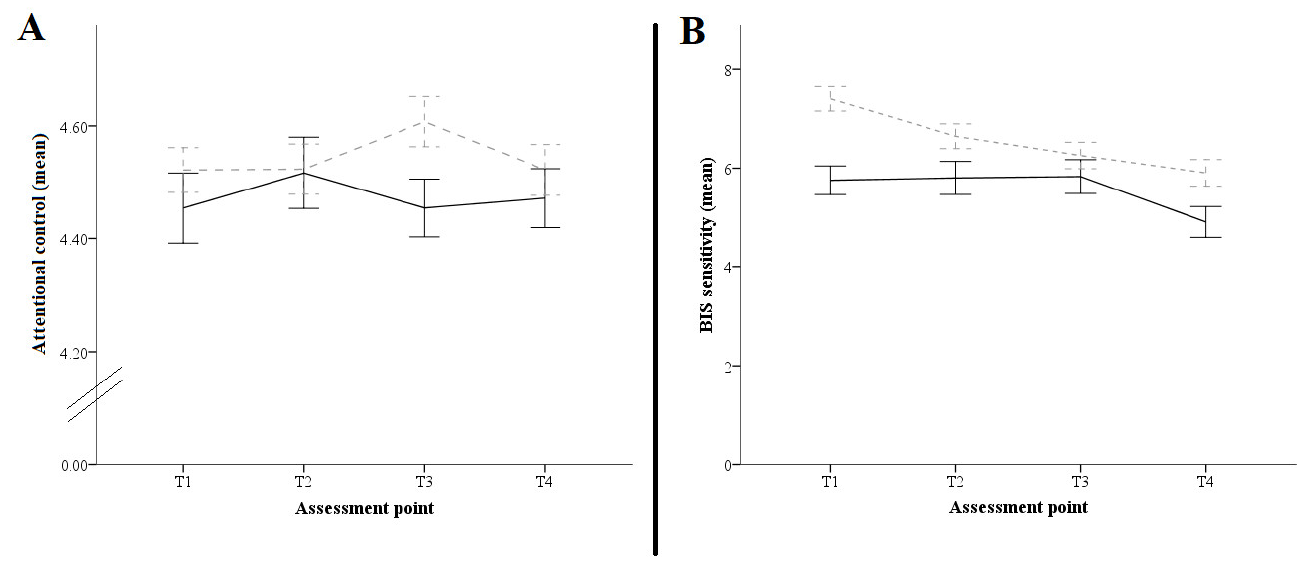
Figure 1. Temperament trajectories according to sex. Box ( A ) shows the attention control trajectories over our assessment period. Box ( B ) displays the behavioral inhibition system sensitivity trajectories over our assessment period. Solid line depicts the trajectories of boys. Dashed line depicts the trajectories of girls. BIS = Behavioral inhibition system. Error bars depict the standard error of the mean.